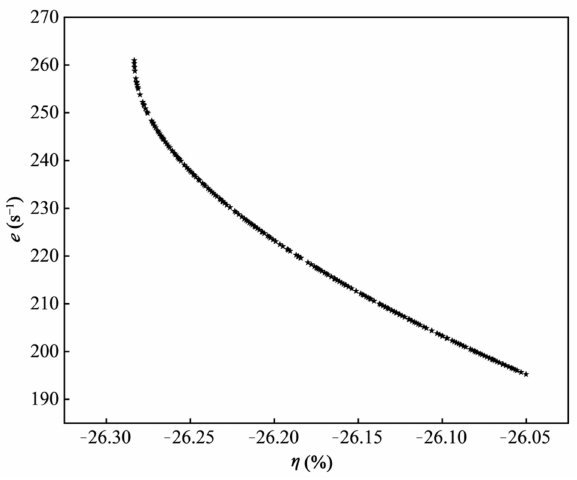
Figure 7. Pareto solution set ( e - η